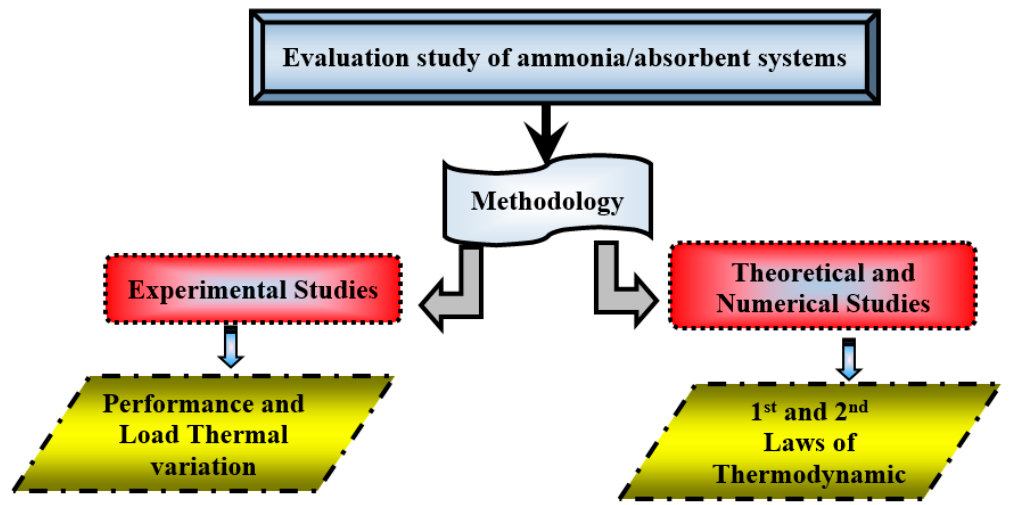
Figure 3. Flowchart of the methods used for the assessment of ammonia/absorbent systems.